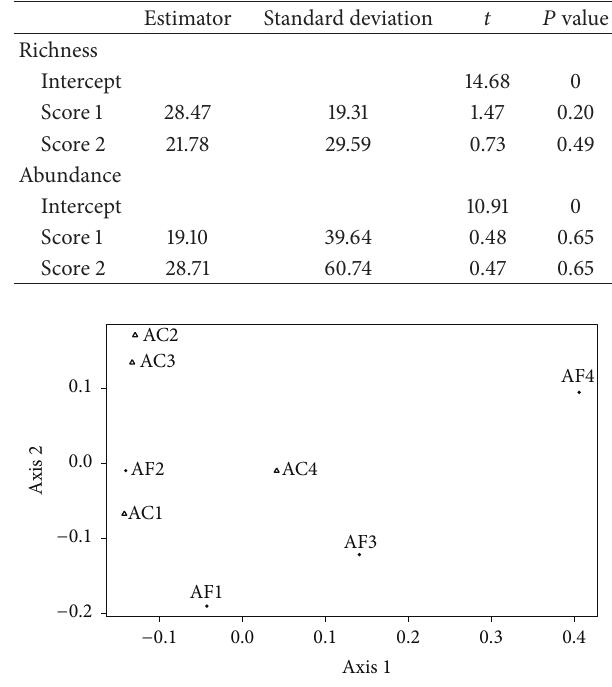
Figure 7: The results of the PCA of the biotic variables recorded in the burned (AF1–4) and control plots